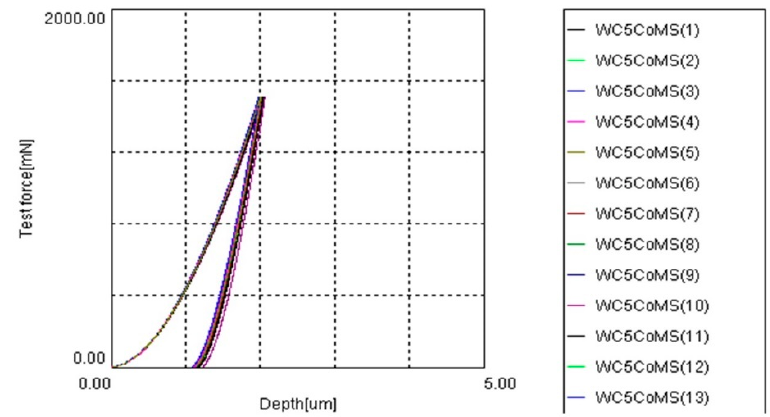
Figure 12. The force-indentation depth curves of the substrate SH-5 .